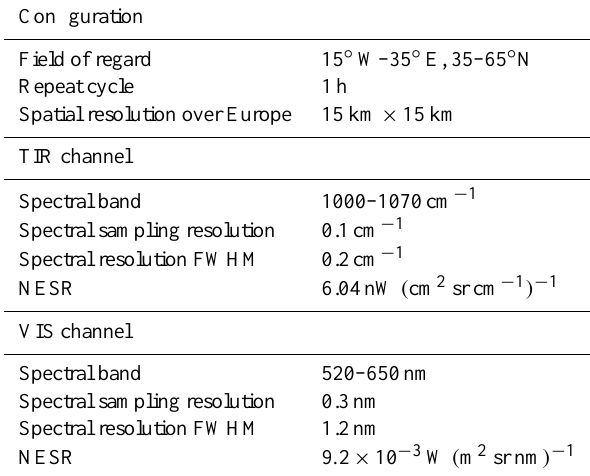
Table 1. Summary of the instrument configurations used. TIR = thermal infrared; VIS = visible; FWHM = full width half maximum; NESR = noise equivalent source